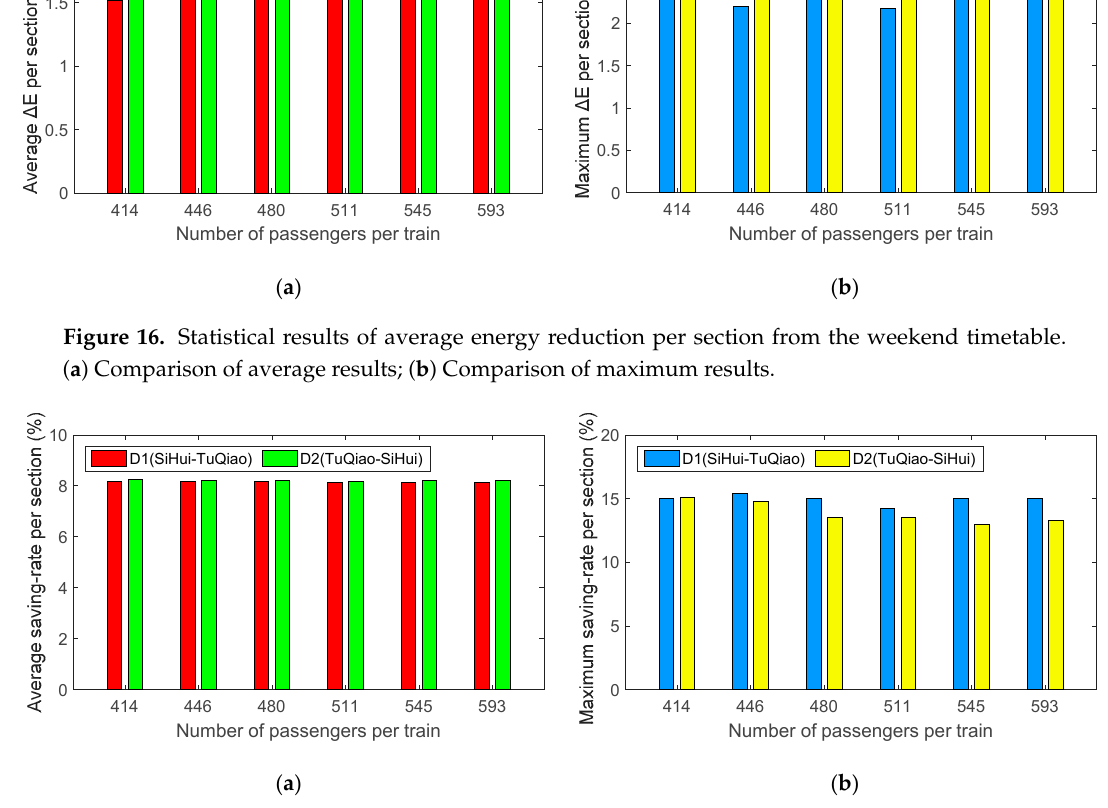
Figure 17. Statistical results of average energy saving rate per section from the weekend timetable. ( a ) Comparison of average results; ( b ) Comparison of maximum results.